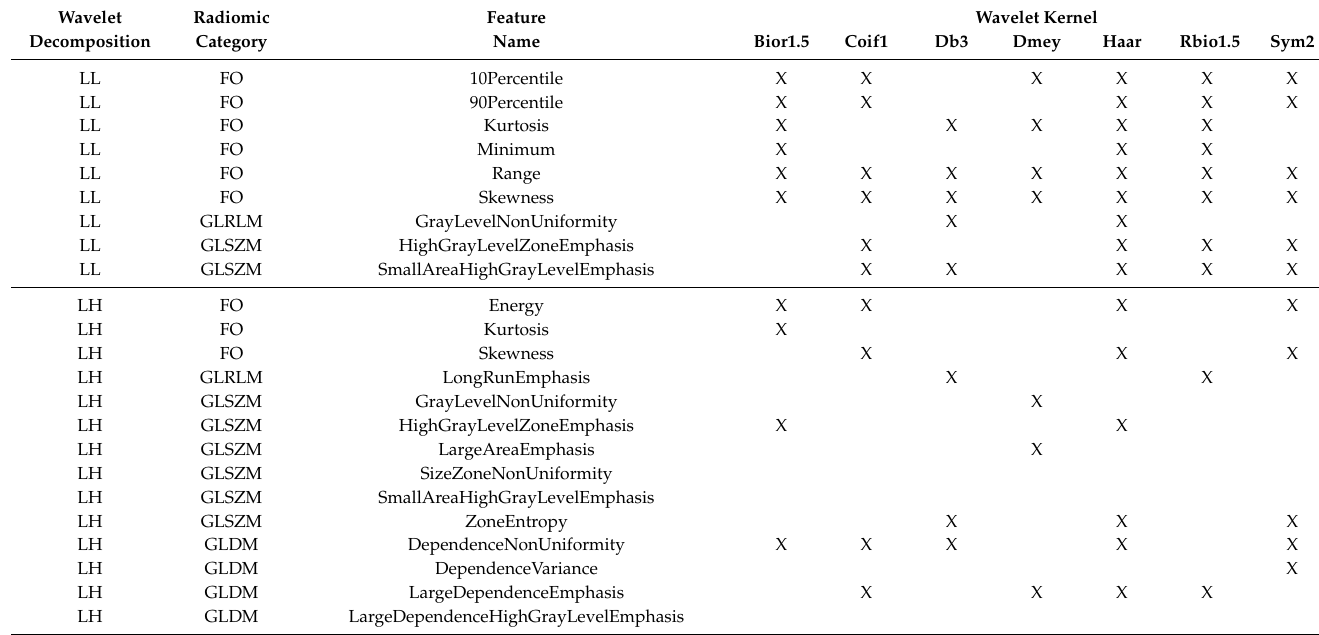
Table A1. Complete list of radiomic features selected via SFS, considering XGB model for each wavelet kernel